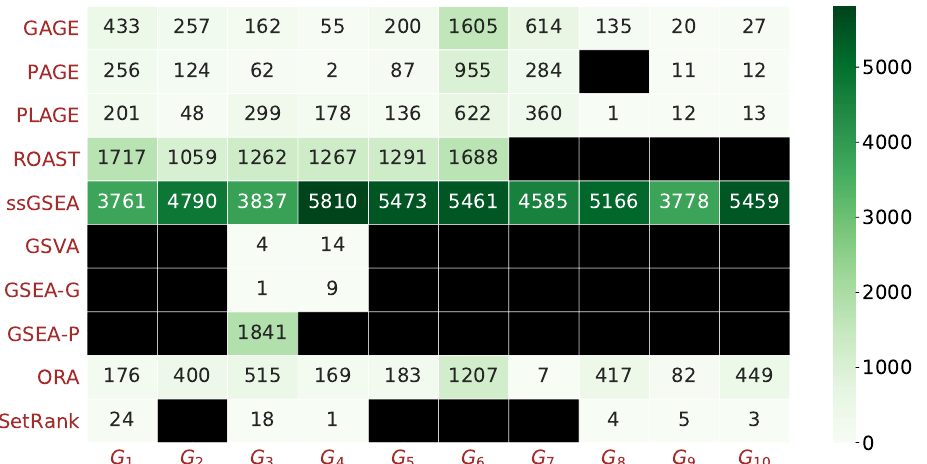
Figure 6. Heat map of the rank of the 10 target gene sets as reported by each method. The results of each method were sorted based on the adjusted p -values (smallest to largest); the rank of each target gene set was determined as its rank in the sorted list. The rank was then recorded in each cell and encoded by the color of the cell, where a darker green indicates a later position in the sorted list. A black cell with no number shows that the adjusted p -value was not less than α = 0.05. Table 4. The sensitivity (TPR) and specificity (TNR) of gene set analysis methods for data simulated from GSE53757. γ = 0.1